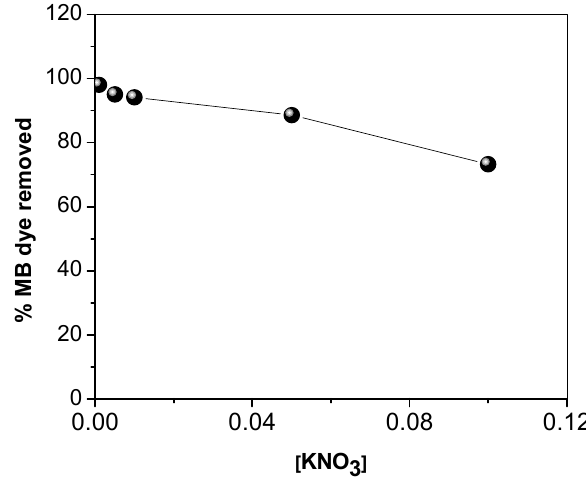
Figure 7. Effect of solution ionic strength on the percentage of methylene blue dye removed from an aqueous solution by SNCM.